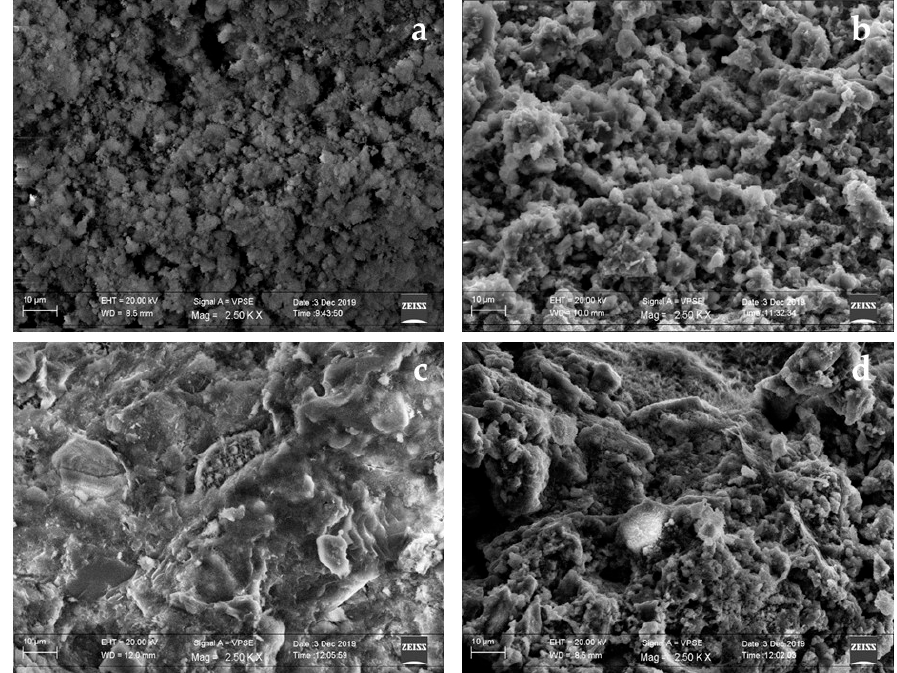
Figure 2. Scanning electron microscope (SEM) images of ( a ) hydraulic lime-based mortar without phase change material (PCM) (HL 800_ LS (Lecce stone)); ( b ) hydraulic lime-based mortar with PCM (HL 800_ LS/PEG (poly(ethylene glycol))); ( c ) cement-based mortar without PCM (C 800_ LS) and ( d ) cement-based mortar with PCM (C 800_ LS/PEG).